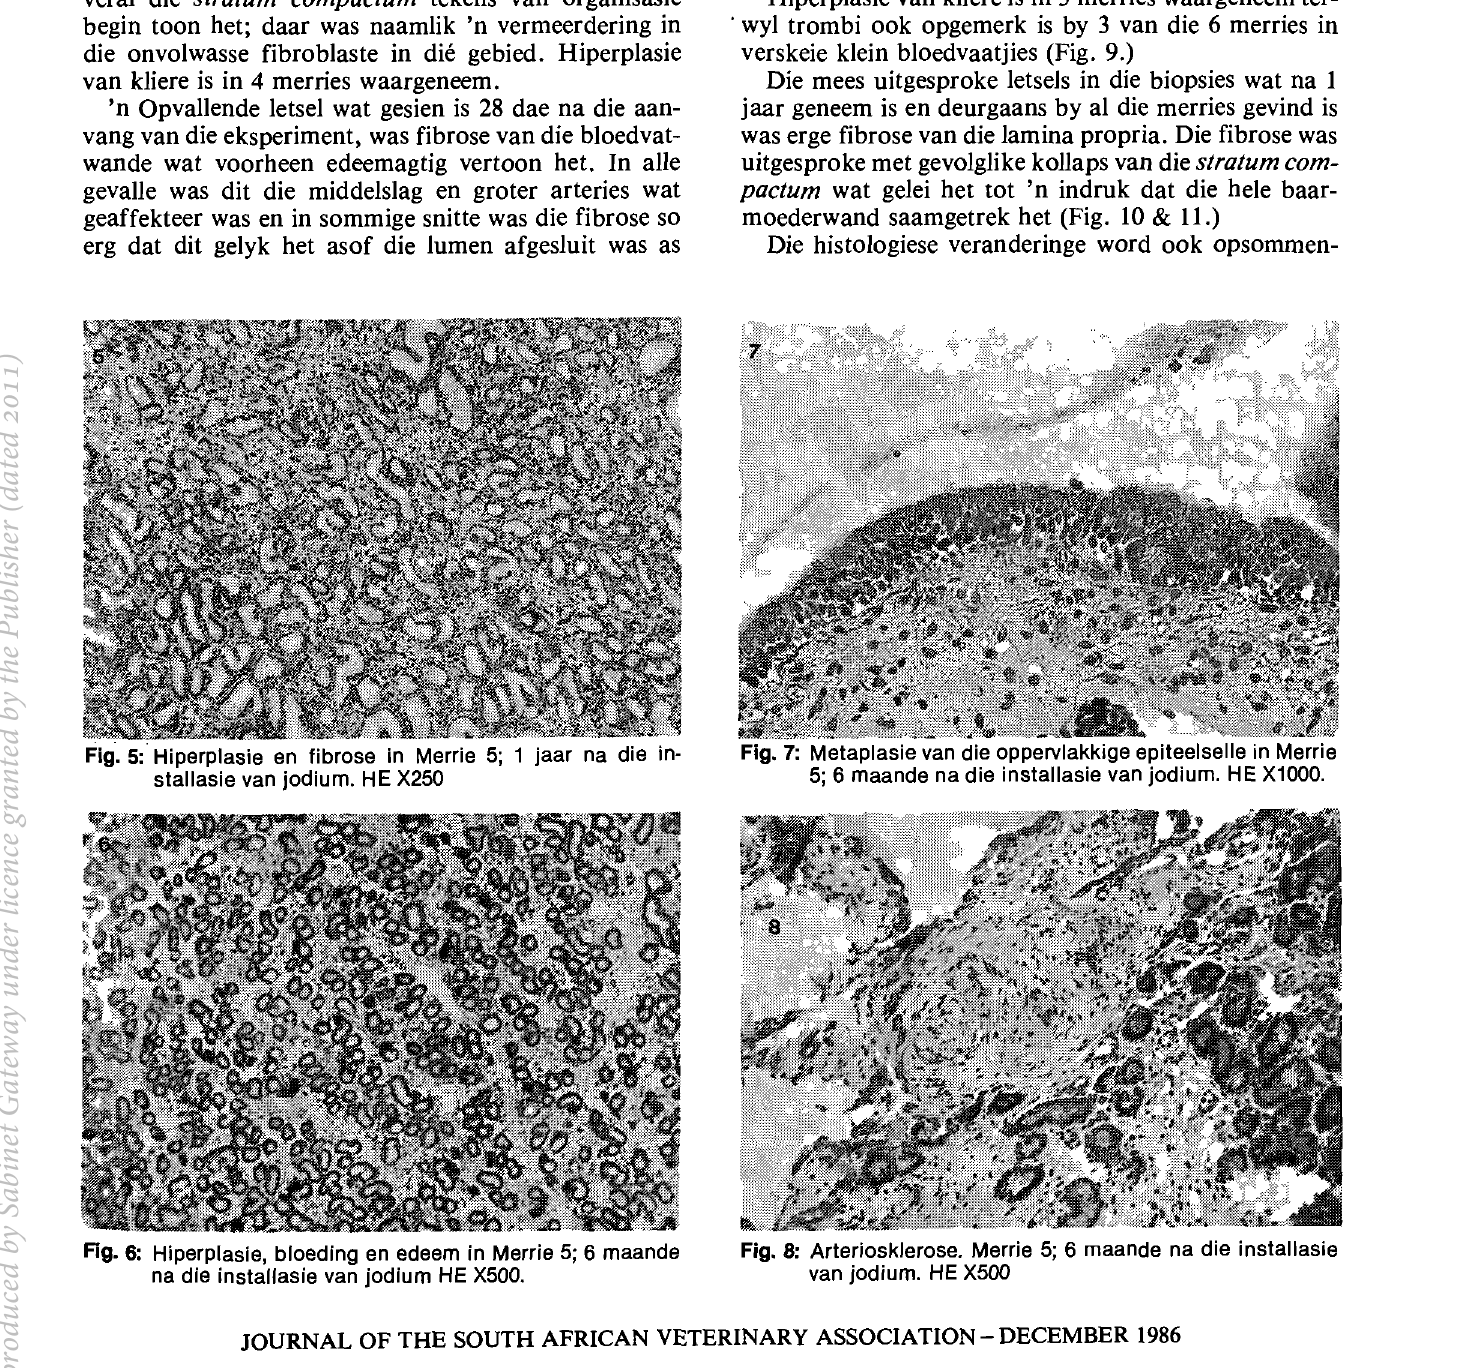
Fig. 8: Arteriosklerose. Merrie 5; 6 maande na die installasie van jodium. HE